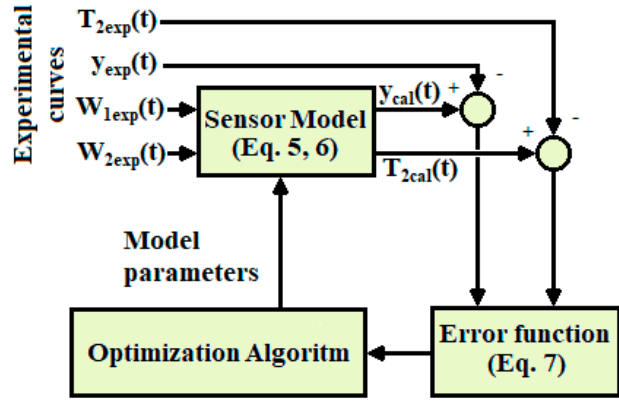
Figure 4. Model calculation procedure.